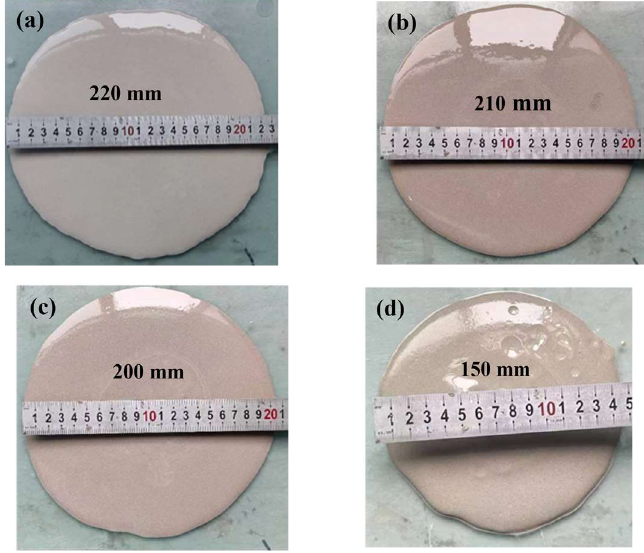
Figure 19. Flow state of slurry at 30 s with different slag content: ( a ) 20%; ( b ) 30%; ( c ) 40%; ( d ) 50%.